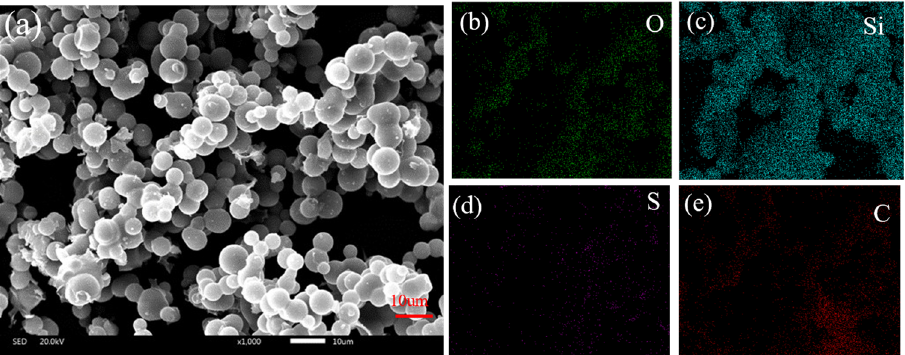
Figure 1. ( a ) Scanning electron microscopy of silica aerogel with PEDOT:PSS; ( b – e ) elemental mapping of silica aerogel with PEDOT:PSS.